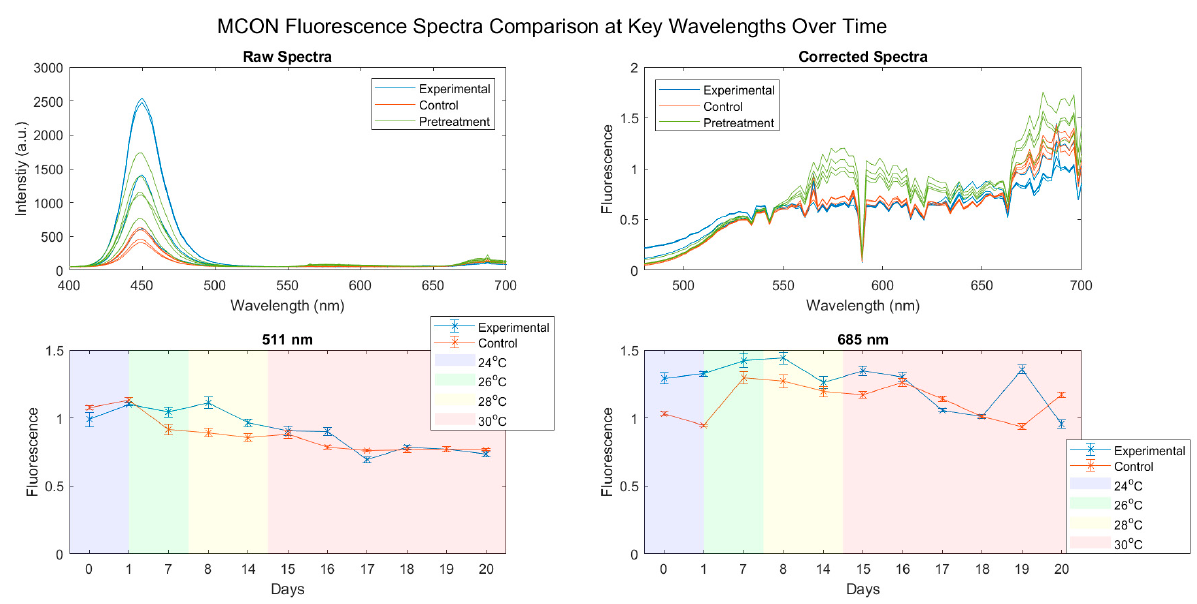
Figure 5. Raw & corrected fluorescence spectra and reflectance of key wavelengths of Montipora confusa (MCON) over time imaged under royal blue (440 nm) light in experiment 2. The average intensity at each wavelength per day of treatment is presented, where the temperature regime is represented as the blue section corresponding to 24 °C (the control stayed at this temperature throughout), green to 26°C, yellow to 28 °C and red to 30 °C.